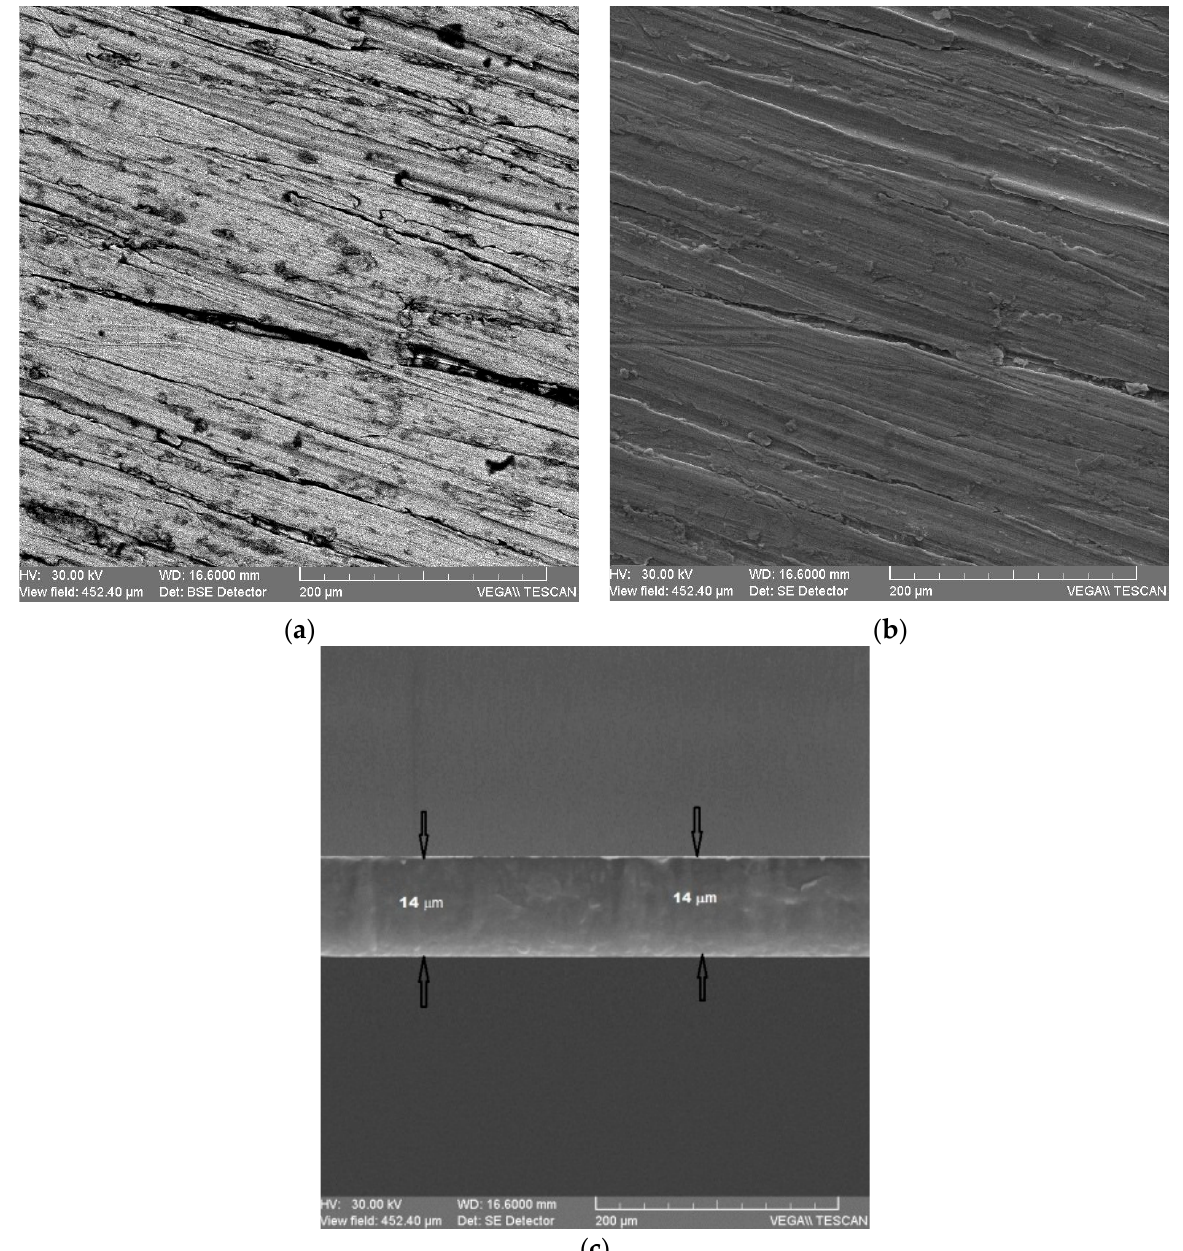
Figure 4. The SEM of ZnO thin films deposited on substrates without enzyme: ( a ) ITO/glass; ( b ) SiO 2 /Si; ( c ) SEM image with 14 µ m thickness of Ag